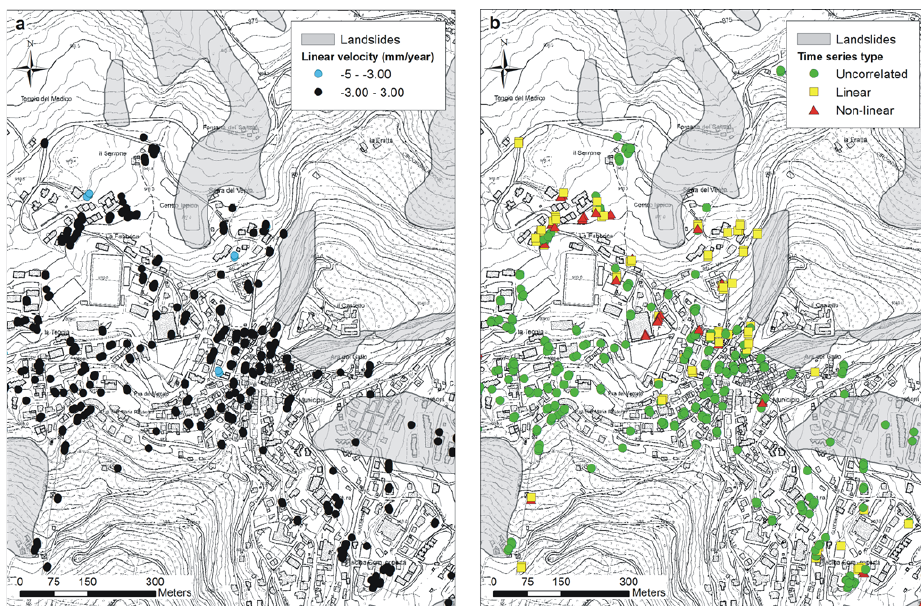
Fig. 11. Sample application of PS-Time to the village of Sestola (Modena province, northern Apennines of Italy). (a) mean velocity obtained by linear regression; (b) time series classification (non-linear class includes types 2 to 5).